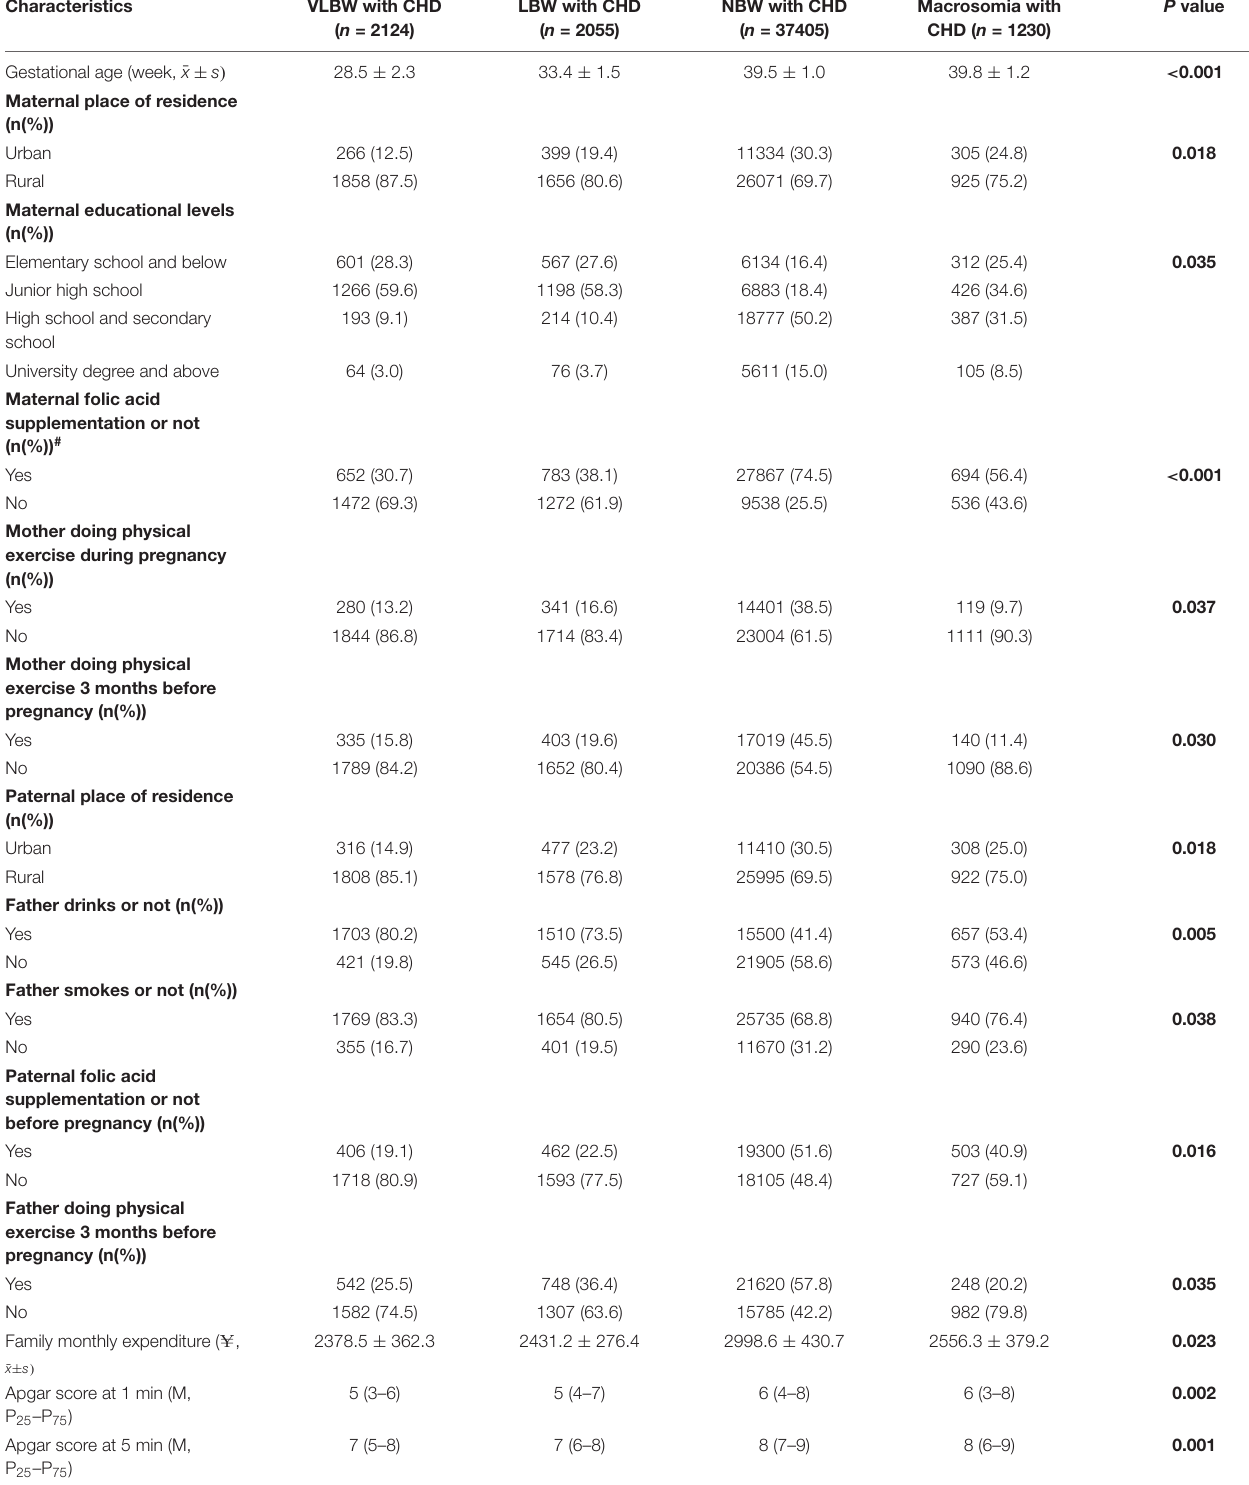
TABLE 2 | Characteristics of children with congenital heart disease at different birth weight groups ( N = 42,814).* Characteristics VLBW with CHD